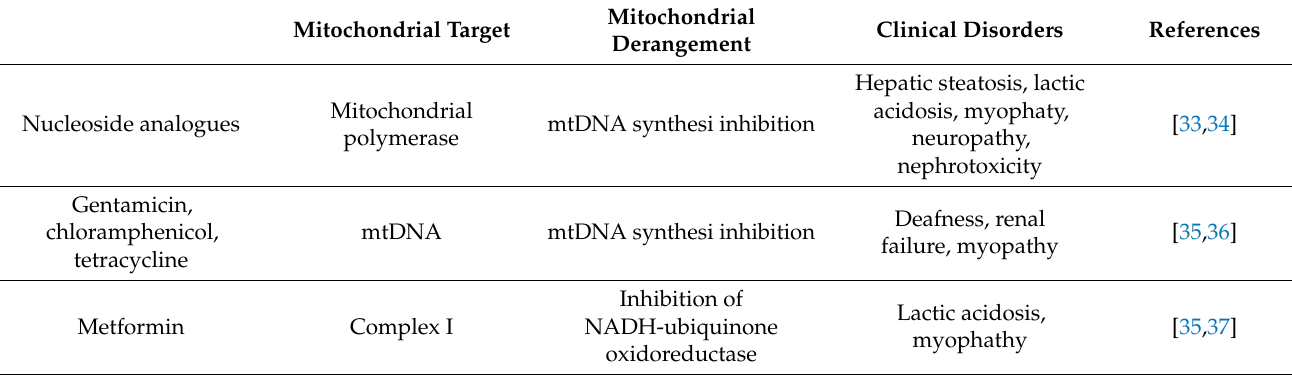
Table 2. Some iatrogenic mitochondrial